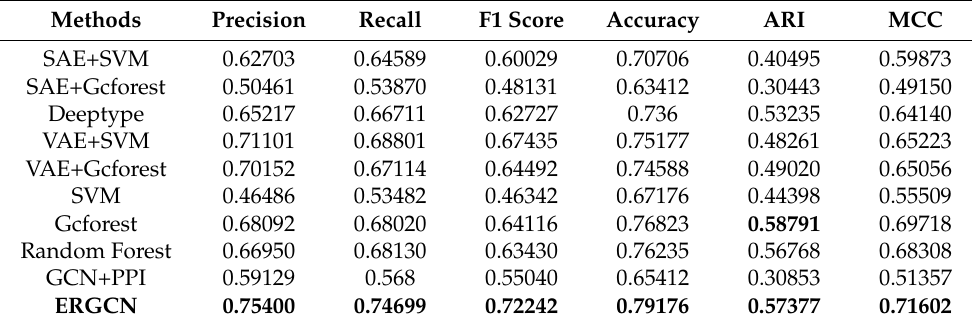
Table 3. The external evaluation metrics of every model on LUNG